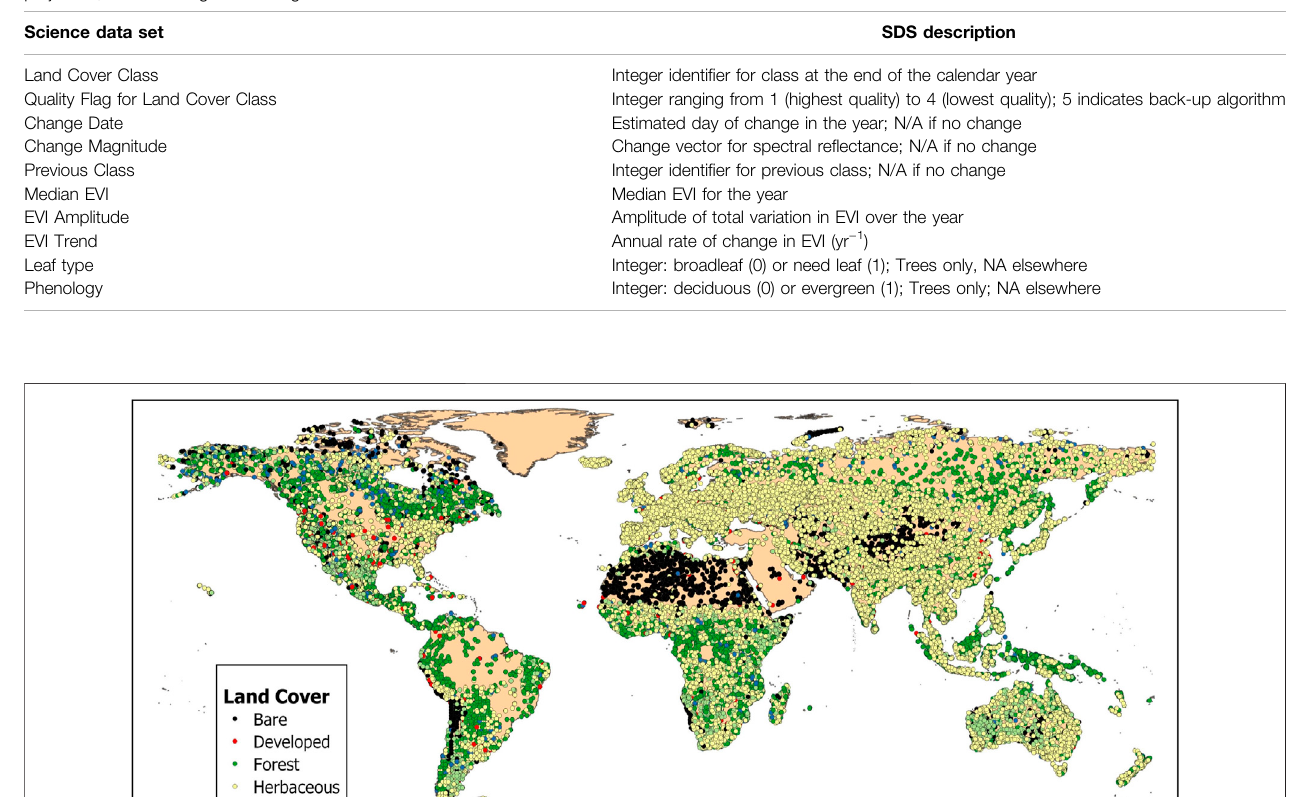
Frontiers in Remote Sensing |